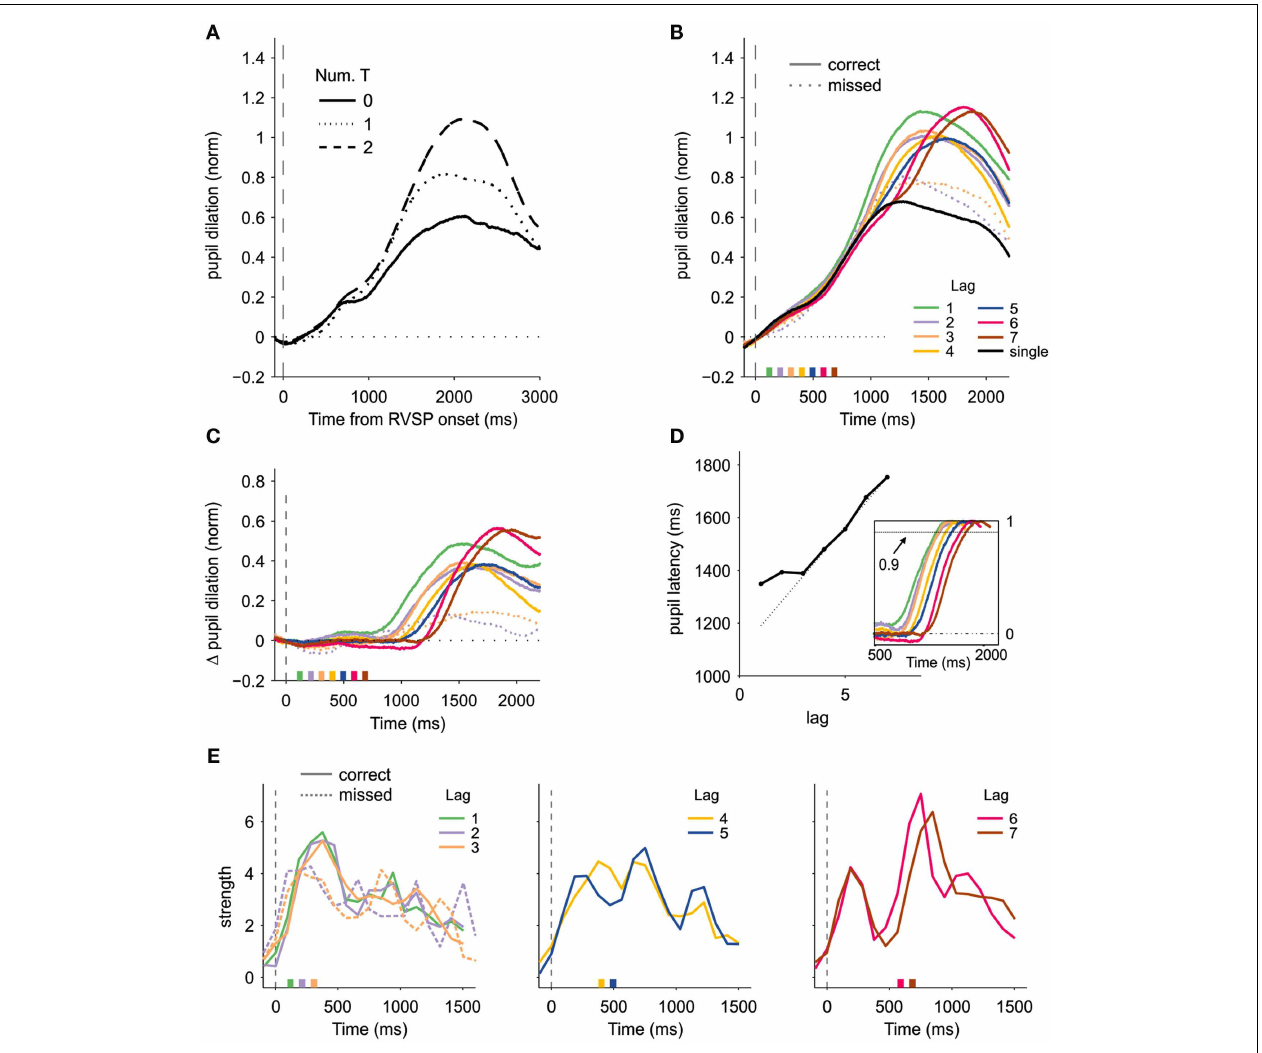
reached 90% of its peak) as a function of lag, showing that the pupil dilation is protracted at short lags. Pupil latencies are shown relative to the onset ofT 2 .The dashed line indicates the expected latency if the pupillary responses were time-locked toT 2 : a good predictor of the actual latency only at long lags.The inset shows the pupillary response [as in (C) ] divided by the peak response at each lag. (E) Strength of the attentional pulses obtained after deconvolving the pupillary response with an impulse response function following the method introduced in (Wierda et al., 2012). Solid lines correspond to correct trials, and dashed lines to blinked trials (only for lags 2 and